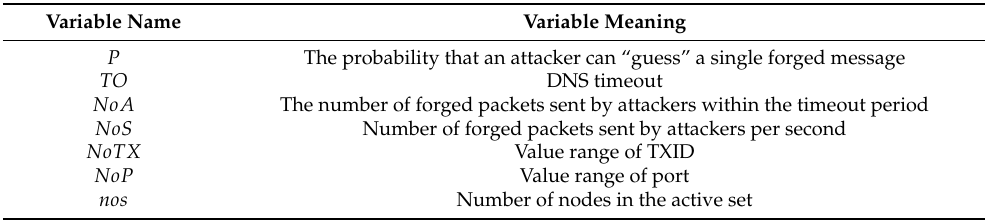
Table 1. Variable name and its